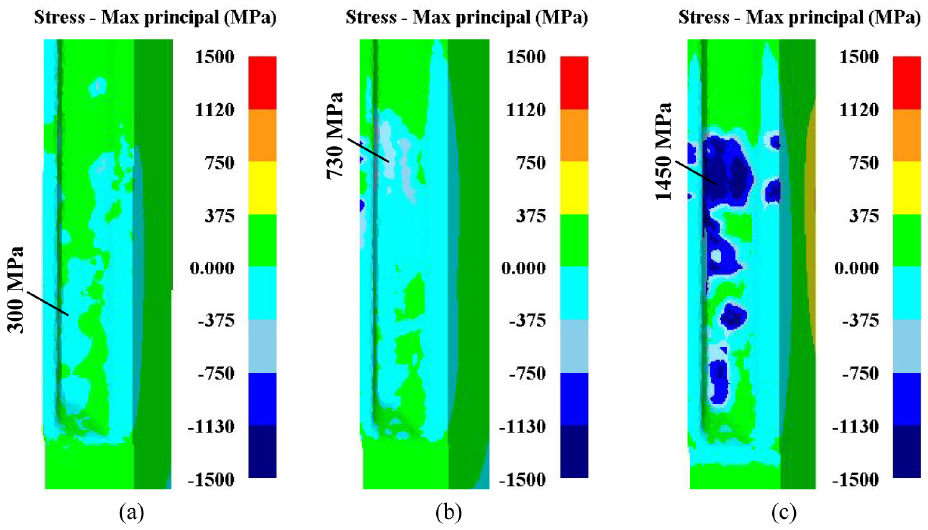
Figure 8. Max principal stress distributions of different spline mandrels: ( a ) Mandrel with gap; ( b ) mandrel without gap; and ( c ) interference mandrel.